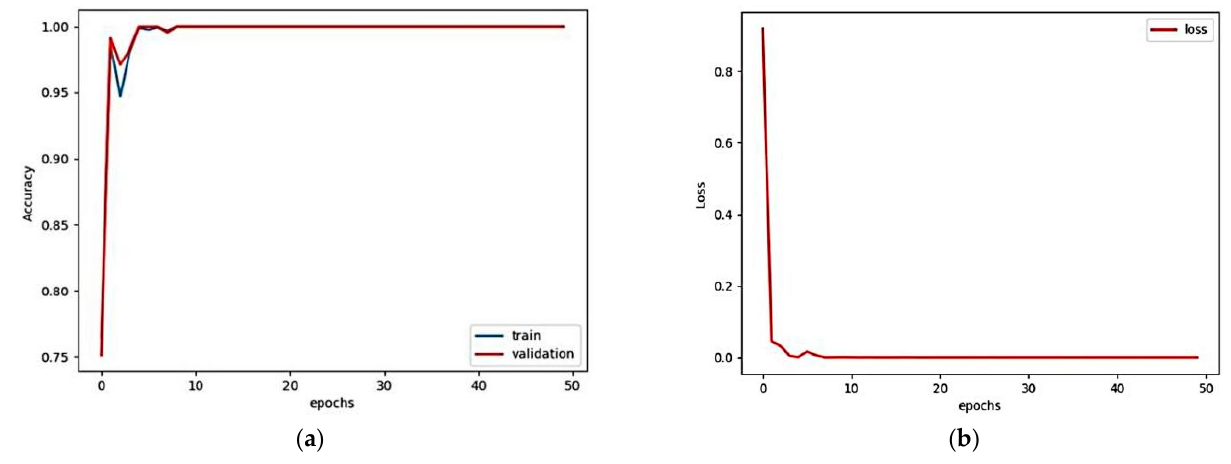
Figure 14. Experimental results. ( a ) The change in accuracy. ( b ) The variation in loss rate.